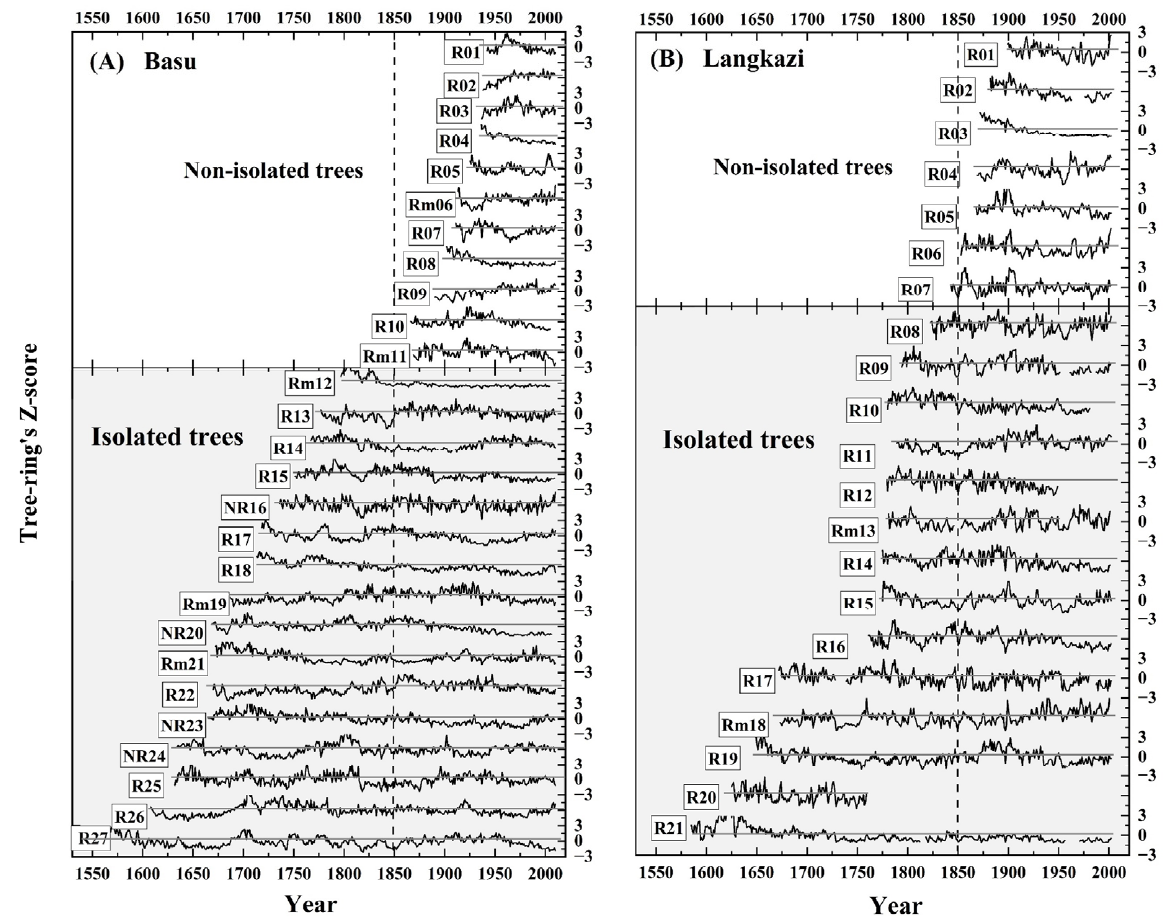
Figure 2. Z-scores of the ring-width sequences of each sampled Juniperus tibetica tree in the Basu treeline ( A ) and the Langkazi treeline ( B ) in Tibet. “R” refers to samples reaching the stem pith. “Rm” refers to samples that are close to the stem pith. “NR” refers to samples not reaching the stem pith. A horizontal line passing the mean of the series was drawn for each tree-ring sequence. At the treelines, trees with a relatively large diameter in stem were chosen for sam- pling. Increment cores were extracted from tree stems at a height roughly 30 cm above the ground. No scars or wounds were observed on the stems of the sampling trees. After